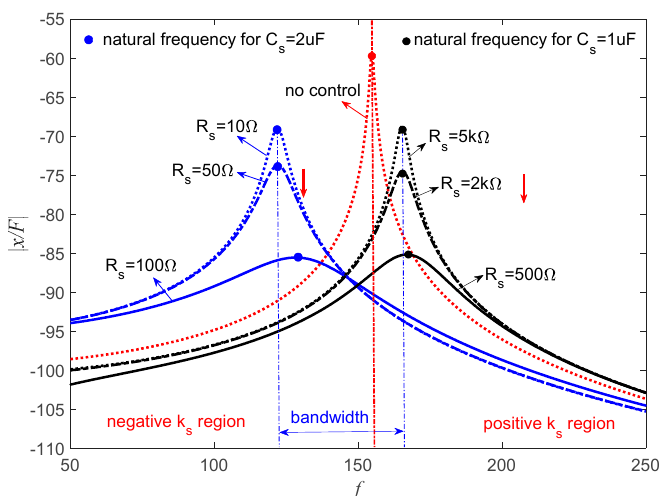
Figure 17. Frequency response of the piezoelectric stack transducer with negative inductance/negative capacitance in series with R s when L s = 10 mH.